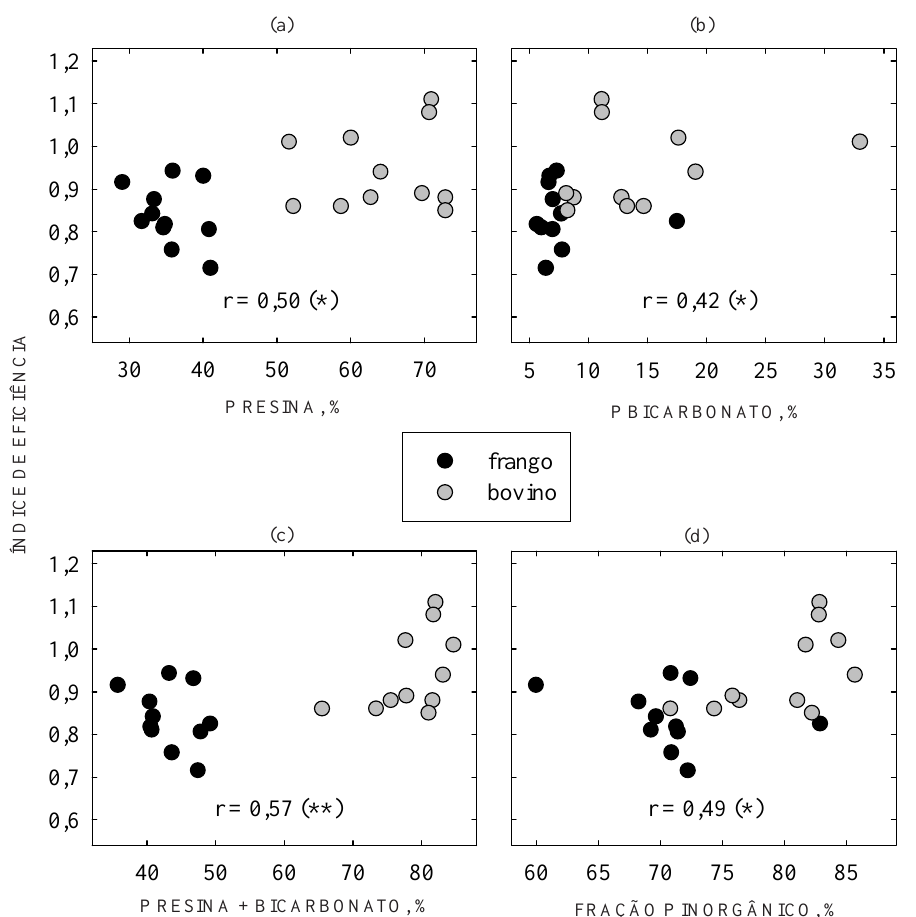
Figura 2. Correlação entre o índice de eficiência relativa de estrumes de frango e de bovino de leite como adubo fosfatado e as proporções do P recuperado em: resina trocadora de ânions (a), bicarbonato de sódio 0,5 mol L -1 (b), soma das frações resina e bicarbonato (c) e somatório das formas inorgânicas (d). (*Significativo a 5%. **Significativo a